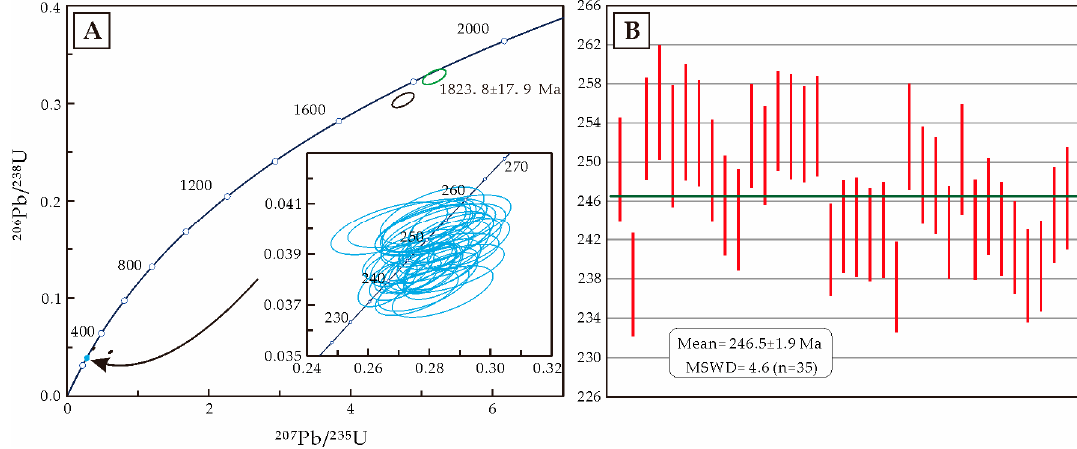
Figure 6. Zircon LA-ICP-MS U–Pb concordia diagrams for the ore-hosting diorite sample 17ZRD01. Zircons separated from sample 17ZRD01 are mostly colorless to pale yellow, transparent, and